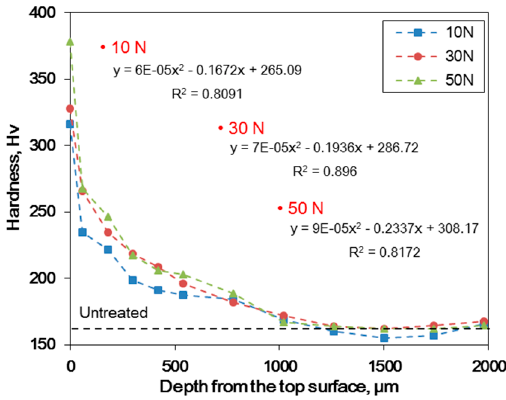
Figure 6. The e ffect of the static load in UNSM treatment on the hardness depth profile of Alloy 600.